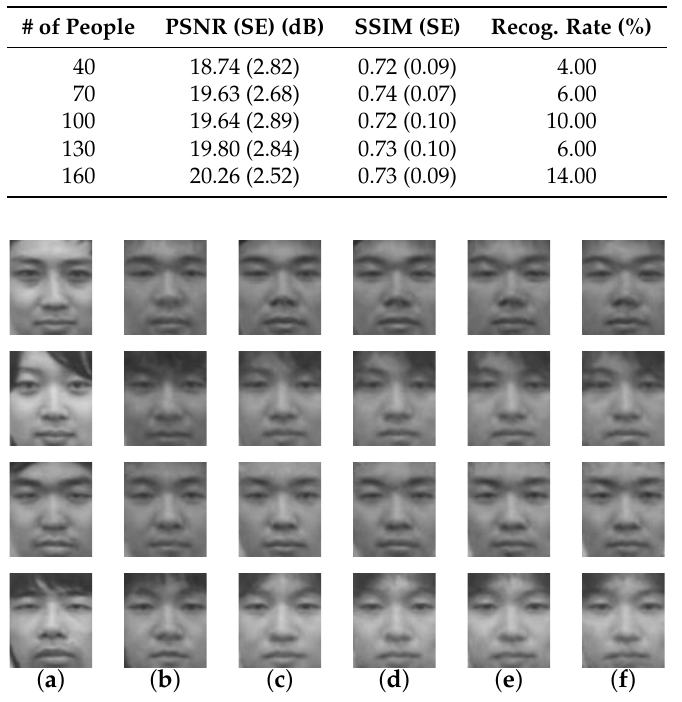
Figure 8. Type B examples of reconstructed images with various number of training data. Each row indicates a person and the columns represent: ( a ) ground-truth images; ( b ) reconstructed images from 40 people’s training data; ( c ) reconstructed images from 70 people’s training data; ( d ) reconstructed images from 100 people’s training data; ( e ) reconstructed images from 130 people’s training data; ( f ) reconstructed images from 160 people’s training